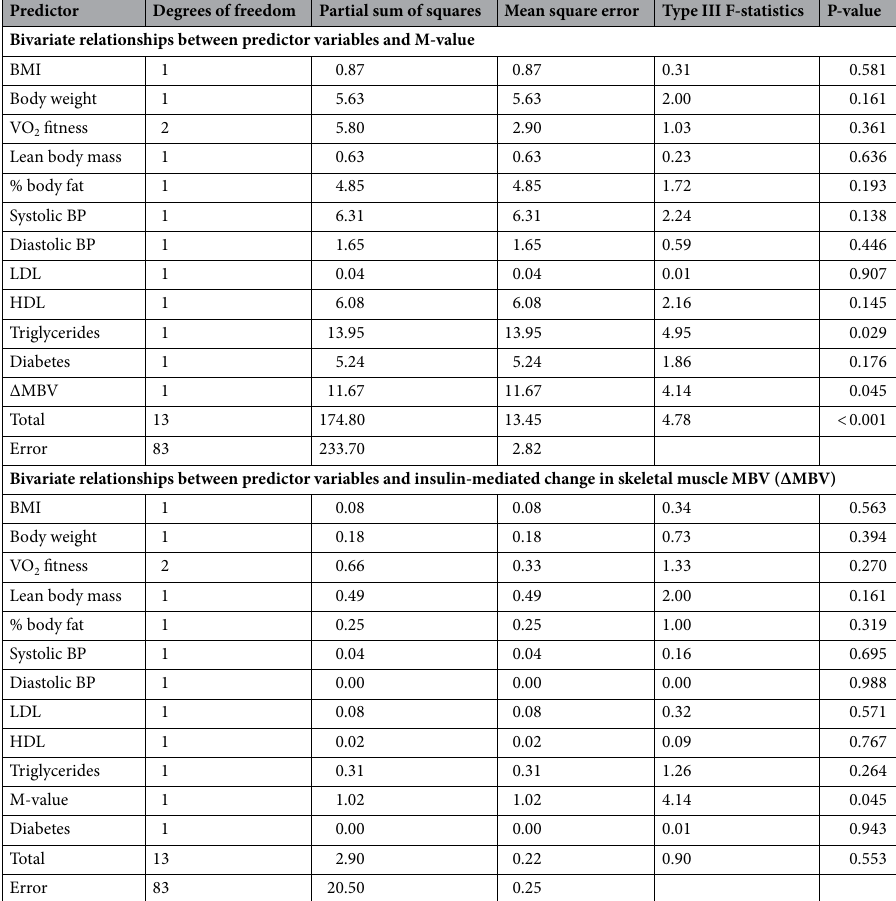
Table 2. Multivariate model ANOVA summary. BMI, body mass index; VO 2 fitness, tertile of cardiorespiratory fitness with 1 representing the highest and 3 representing the lowest level of fitness; LDL, low-density lipoprotein cholesterol; HDL, high-density lipoprotein